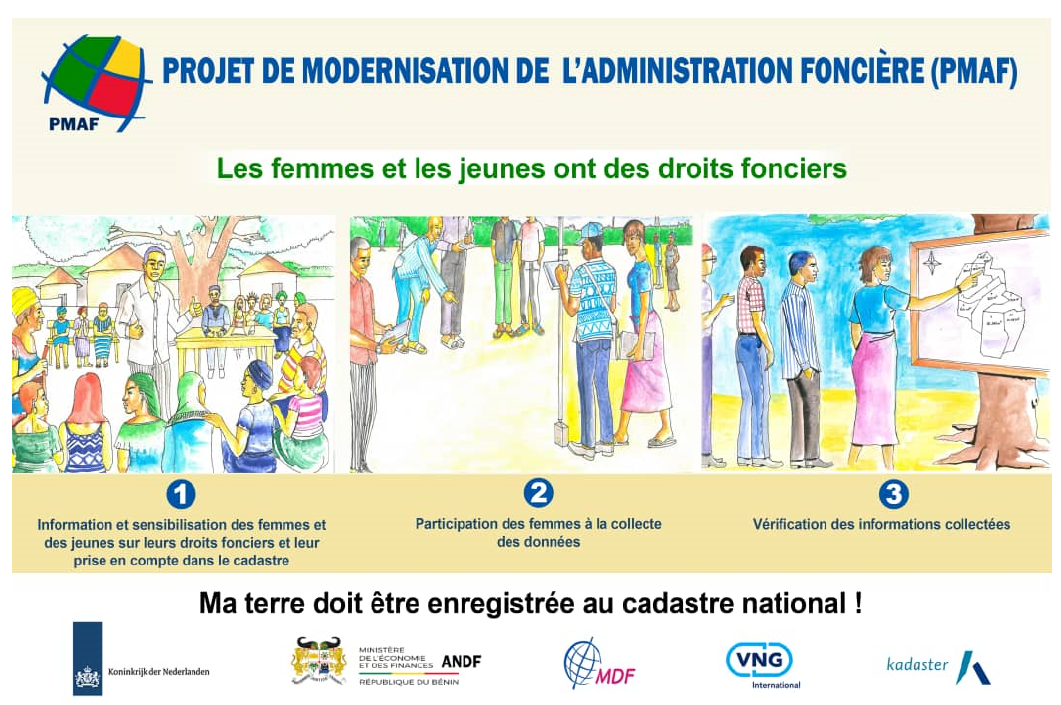
Figure 7. Example of information material.